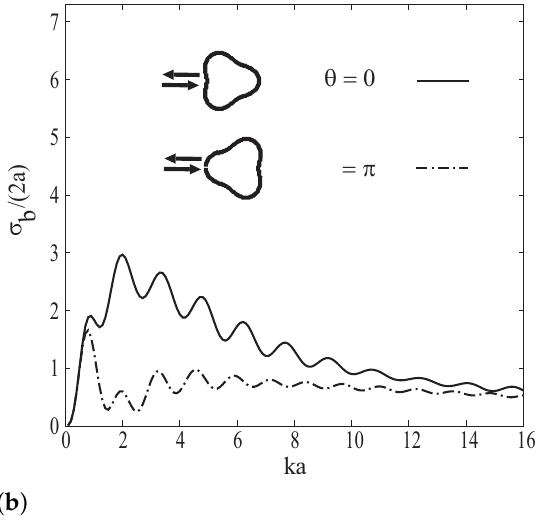
Figure 4. Target size versus LRCS in free space for kW = 2.5 where ( a ) δ = 0.08, ( b ) δ = 0.12.